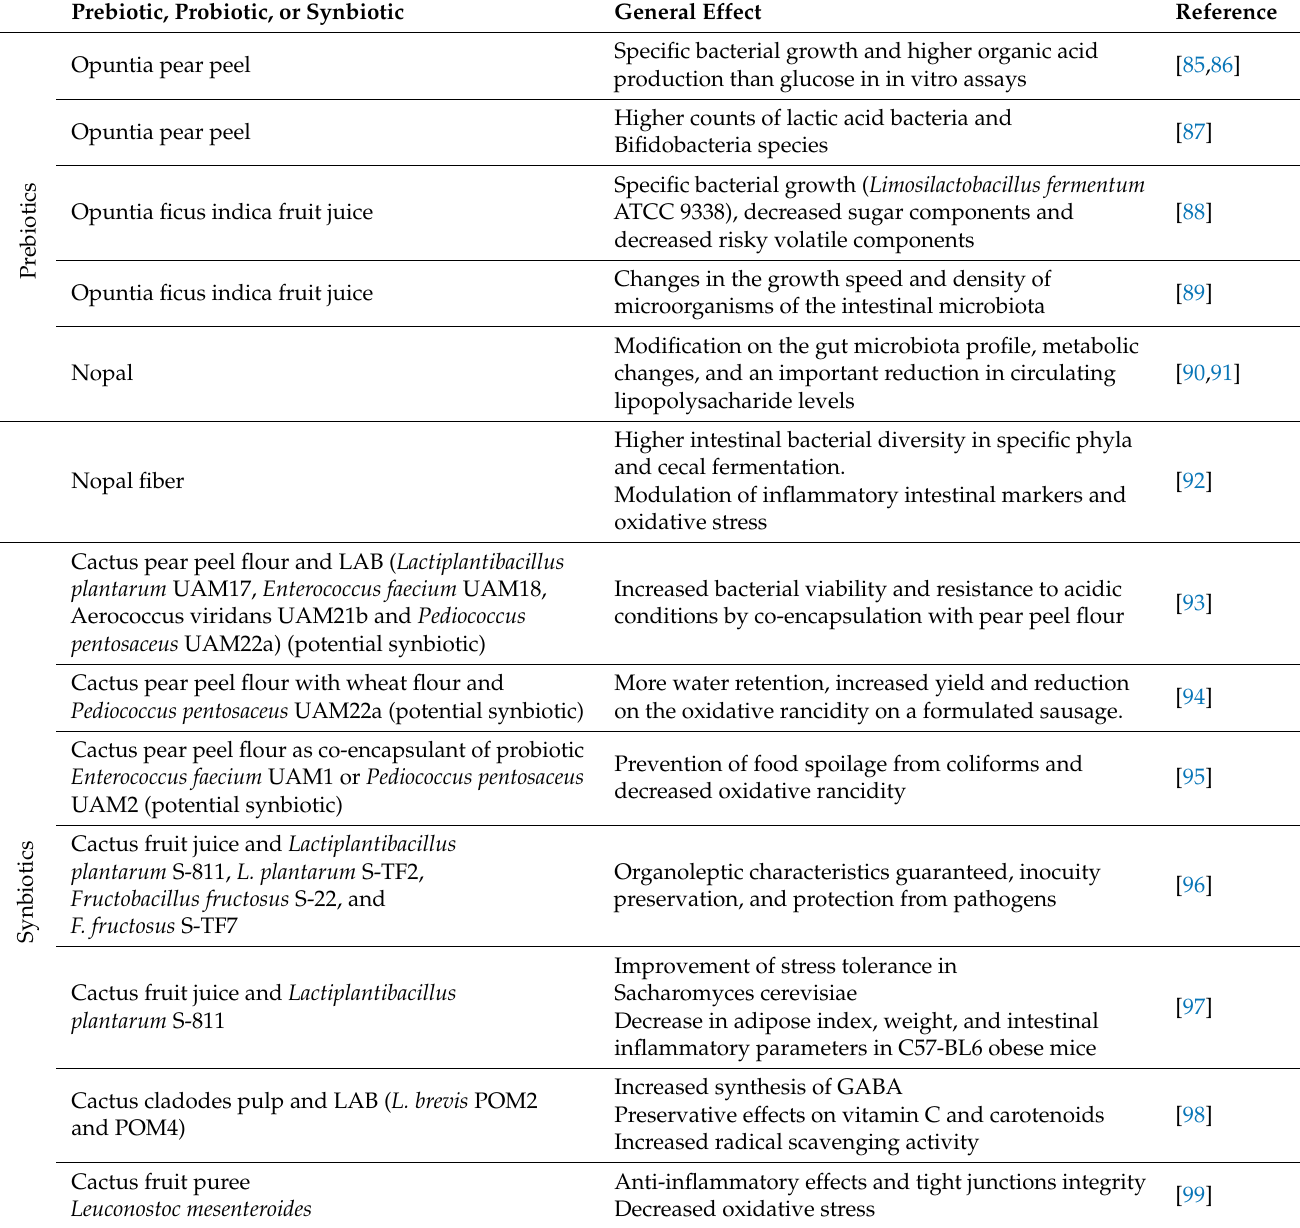
Table 3. Prebiotics and Synbiotics in